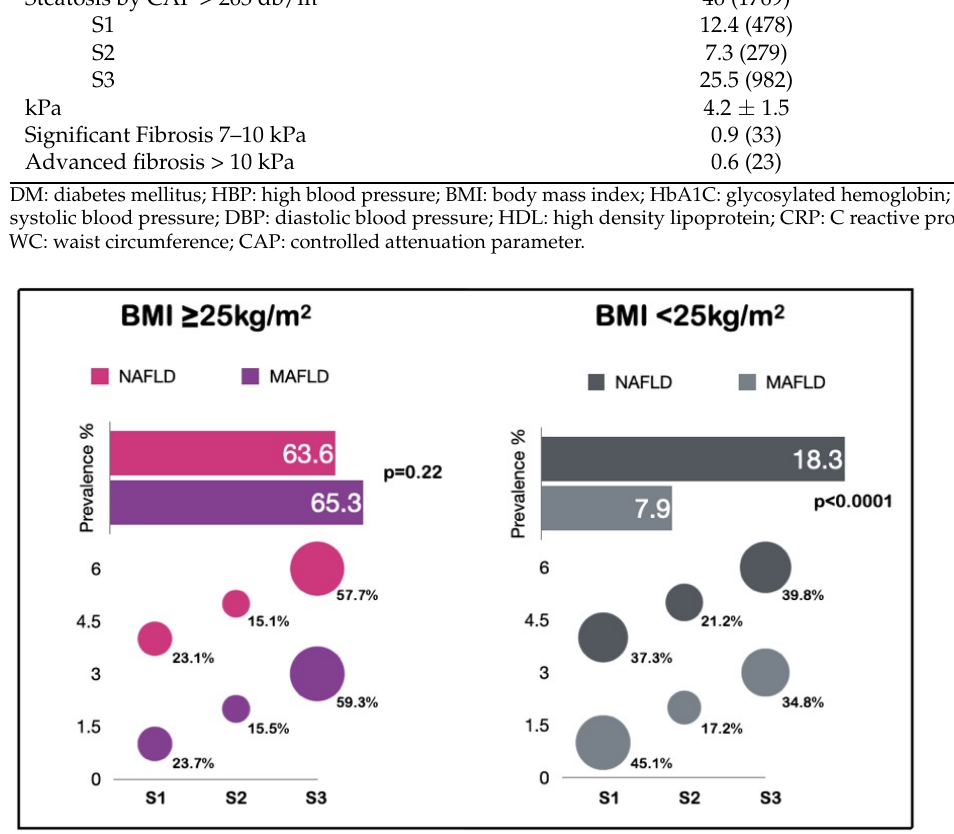
Figure 1. Differences on prevalence according to NAFLD and MAFLD criteria. BMI: body mass index; NAFLD: non ‐ alcoholic fatty liver disease; MAFLD: metabolic dysfunction ‐ associated fatty liver disease; S1 263–282 dB/m; S2 283–295 dB/m; S3 > 296 dB/m. Table 3. Differences in clinical and demographic characteristics of NAFLD and MAFLD criteria in patients with BMI < 25 kg/m 2 .